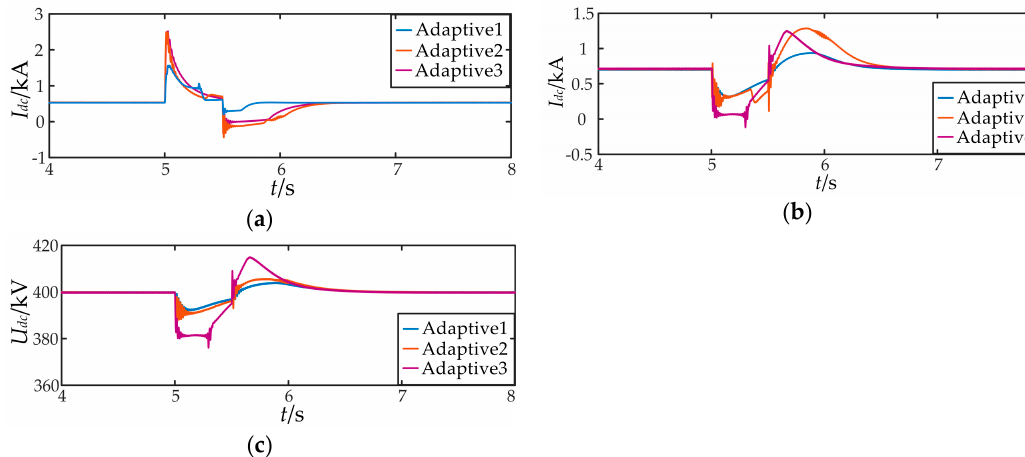
Figure 20 . Simulation waveforms of a three-phase short circuit fault in the AC grid on the LCC3 side: ( a ) DC current of LCC3; ( b ) DC current of LCC4; ( c ) DC voltage. Where Adaptive1, Adaptive2, and Adaptive3 denote the adaptive droop control strategy proposed in this paper, the adaptive droop control based on DC voltage deviation, and the adaptive droop control based on the DC voltage deviation coefficient and power distribution coefficient, respectively.